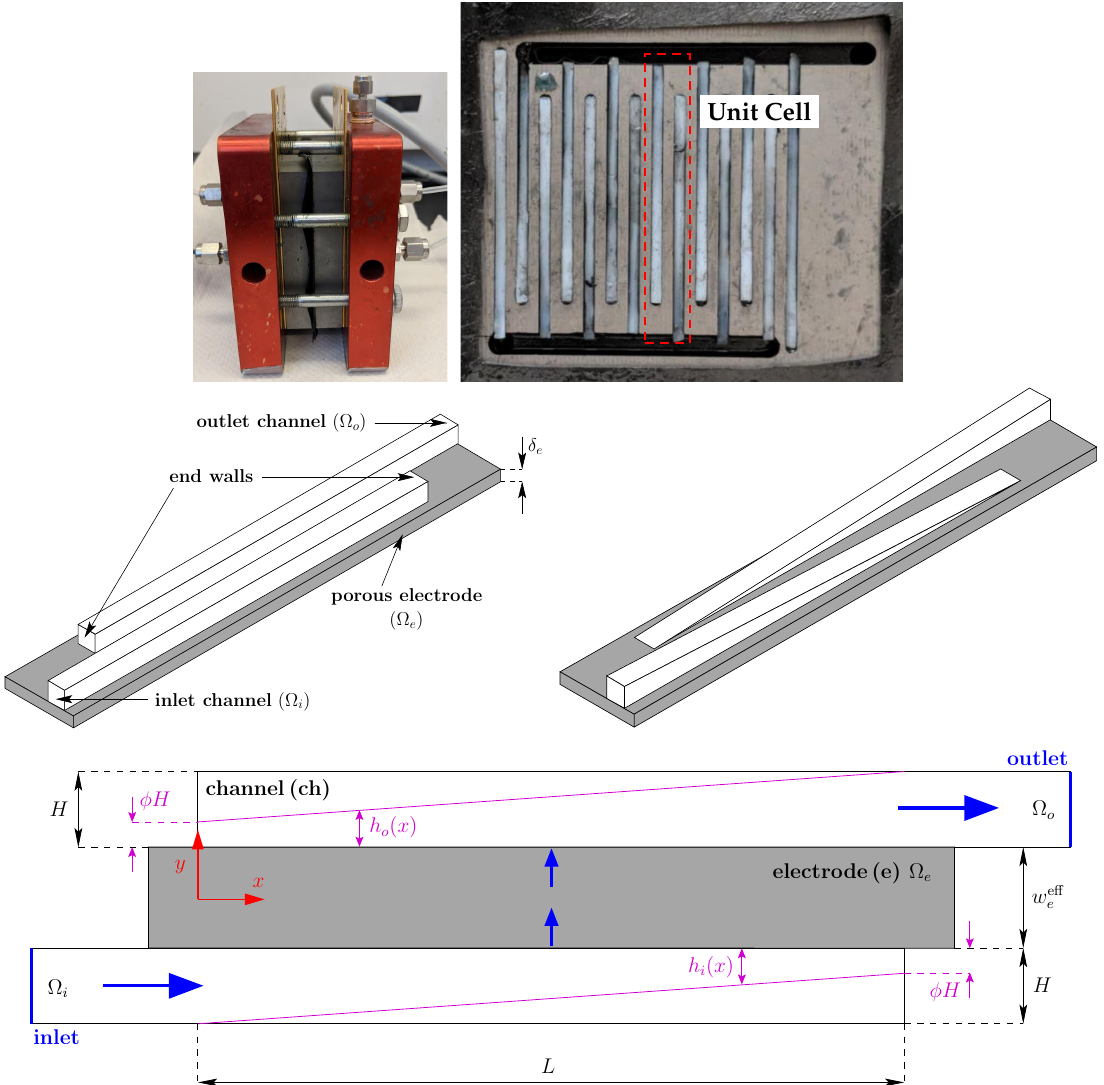
Figure 1. (top) Cell fixture and constant cross-section interdigitated flow field used in the experiments, indicating the repeating unit cell, (middle) schematic representation of the 3D geometry of a unit cell of an interdigitated flow field with constant cross-section and tapered channels, and (down) the simplified 2D along-the-channel geometry used in the CFD model. The flow direction (blue arrows), the notation used for the geometrical parameters and the coordinate system are